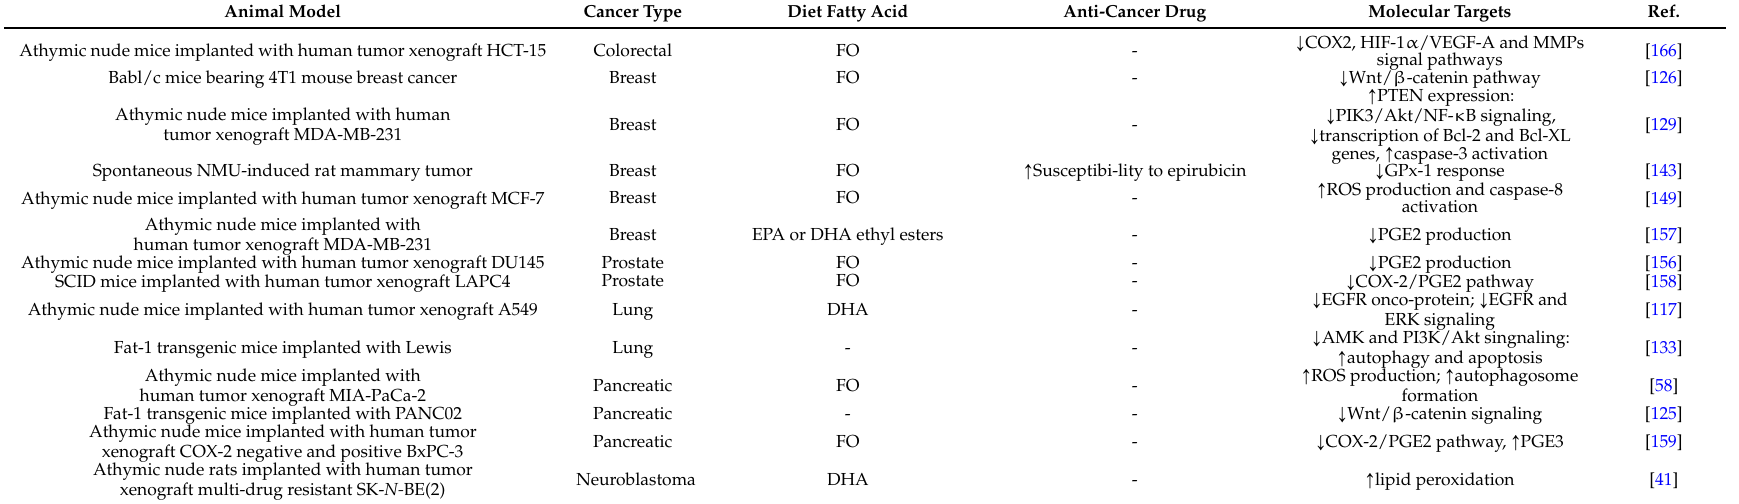
Table 3. Overview of studies investigating apoptotic targets involved in the suppression of tumor growth by n- 3 PUFAs in animal models. Animal